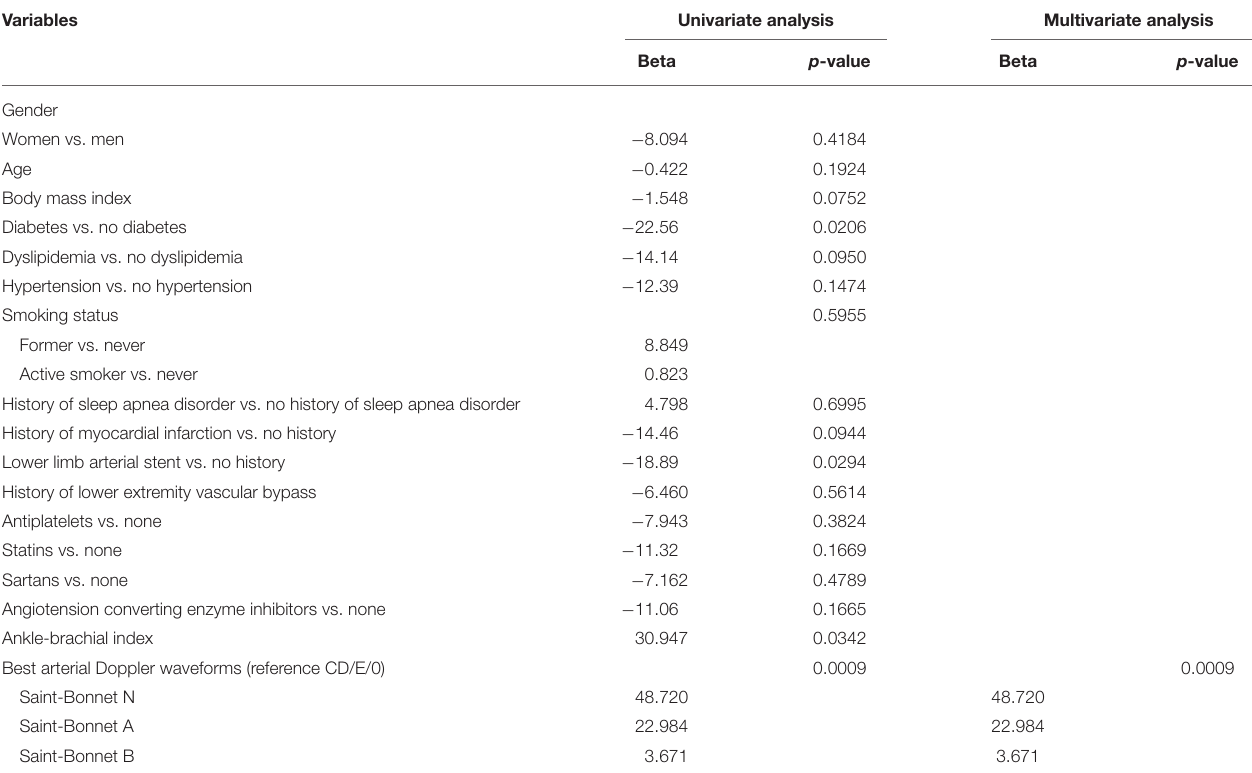
TABLE 3 | Univariate and multivariate analysis findings including patient characteristics and clinical readings at rest (ABI and Doppler waveforms) in suspected LEAD population ( n =